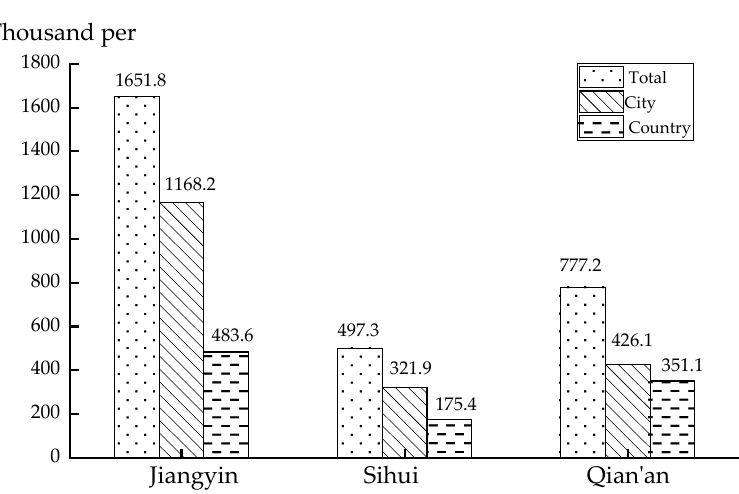
Figure 8. Population size of countries.